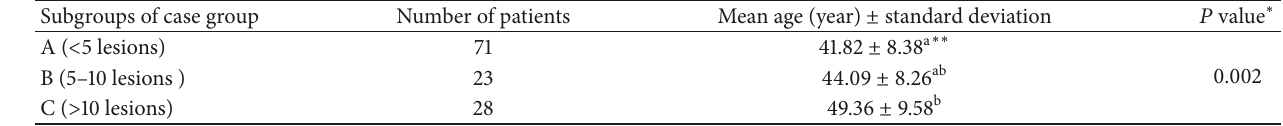
Table 3: Mean age in subgroups of patients with cherry